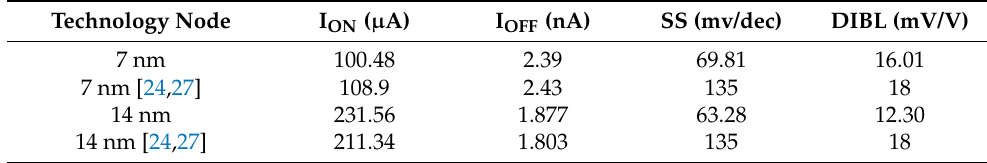
Table 4. Comparative results of CNFET model with experimental data.